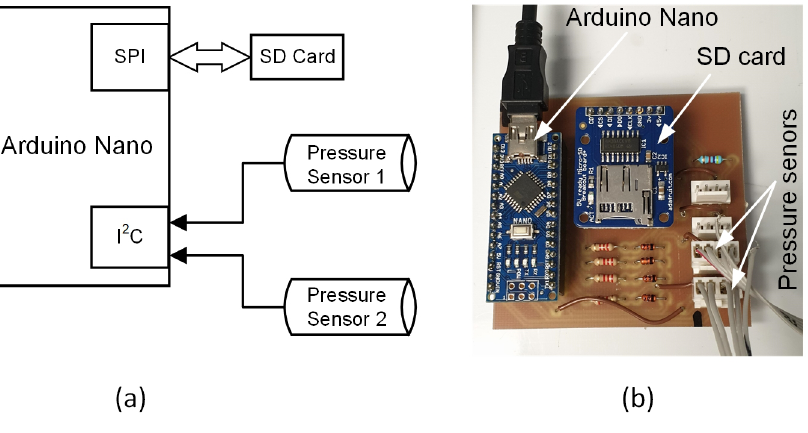
Figure 3. Sensor interface electronics. ( a ) Block diagram of the measurement electronics. ( b ) Actual measurement